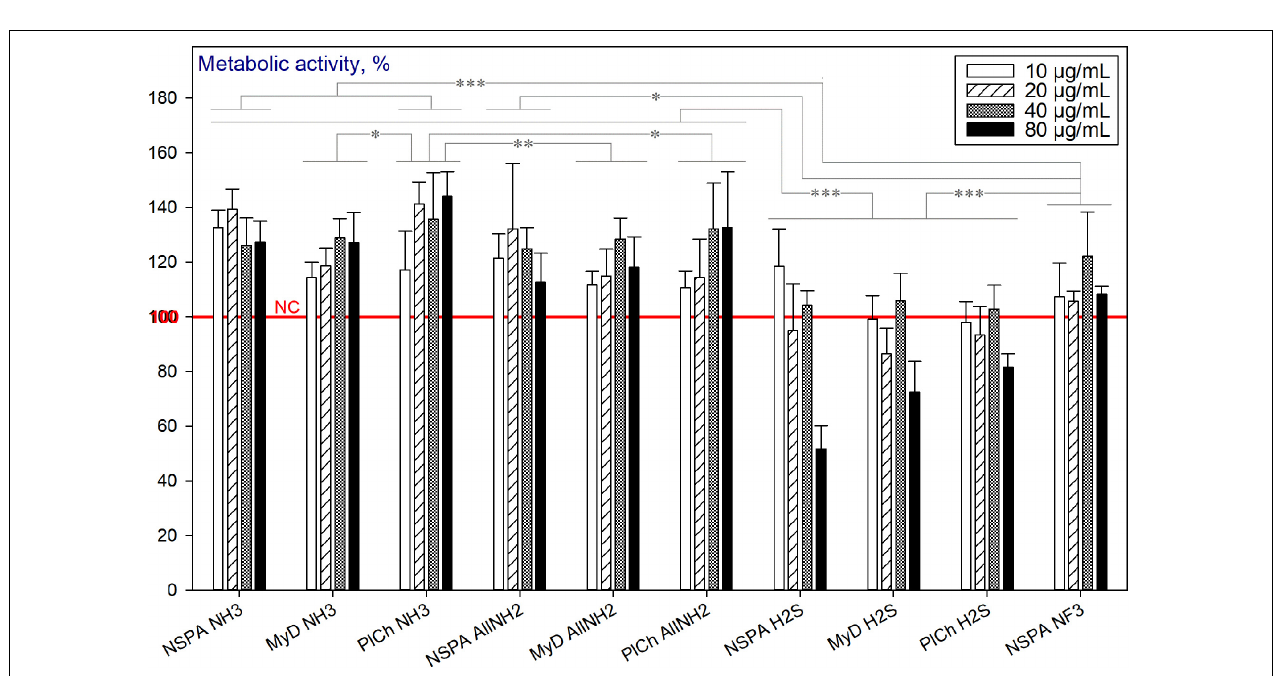
FIGURE 13 | Metabolic activity of HDFs cultured with plasma-modified DND, using the alamarBlueTM assay (normalised to the non-treated cells; n = 3; ∗∗∗ p < 0.001; ∗∗ p < 0.01; ∗ p < 0.05; ± SD).